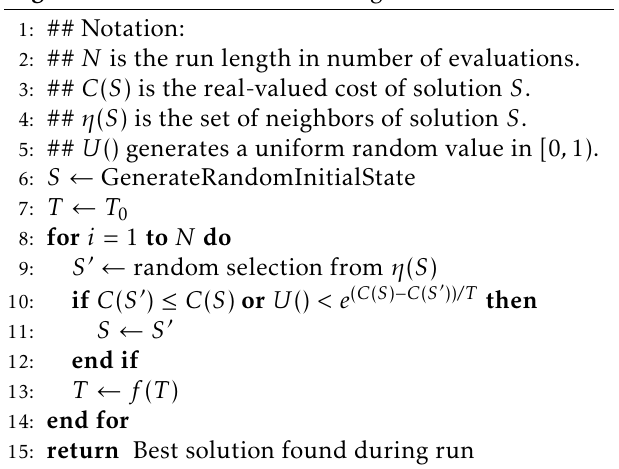
Algorithm 1 Simulated